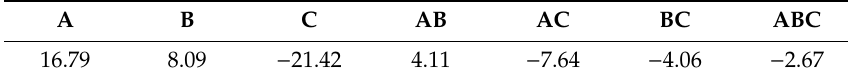
Figure 7. Effects of individual input factors, A, B, and C, and their interactions, AB, AC, BC, and ABC . Table 7. Estimates of factor effects (wt %).